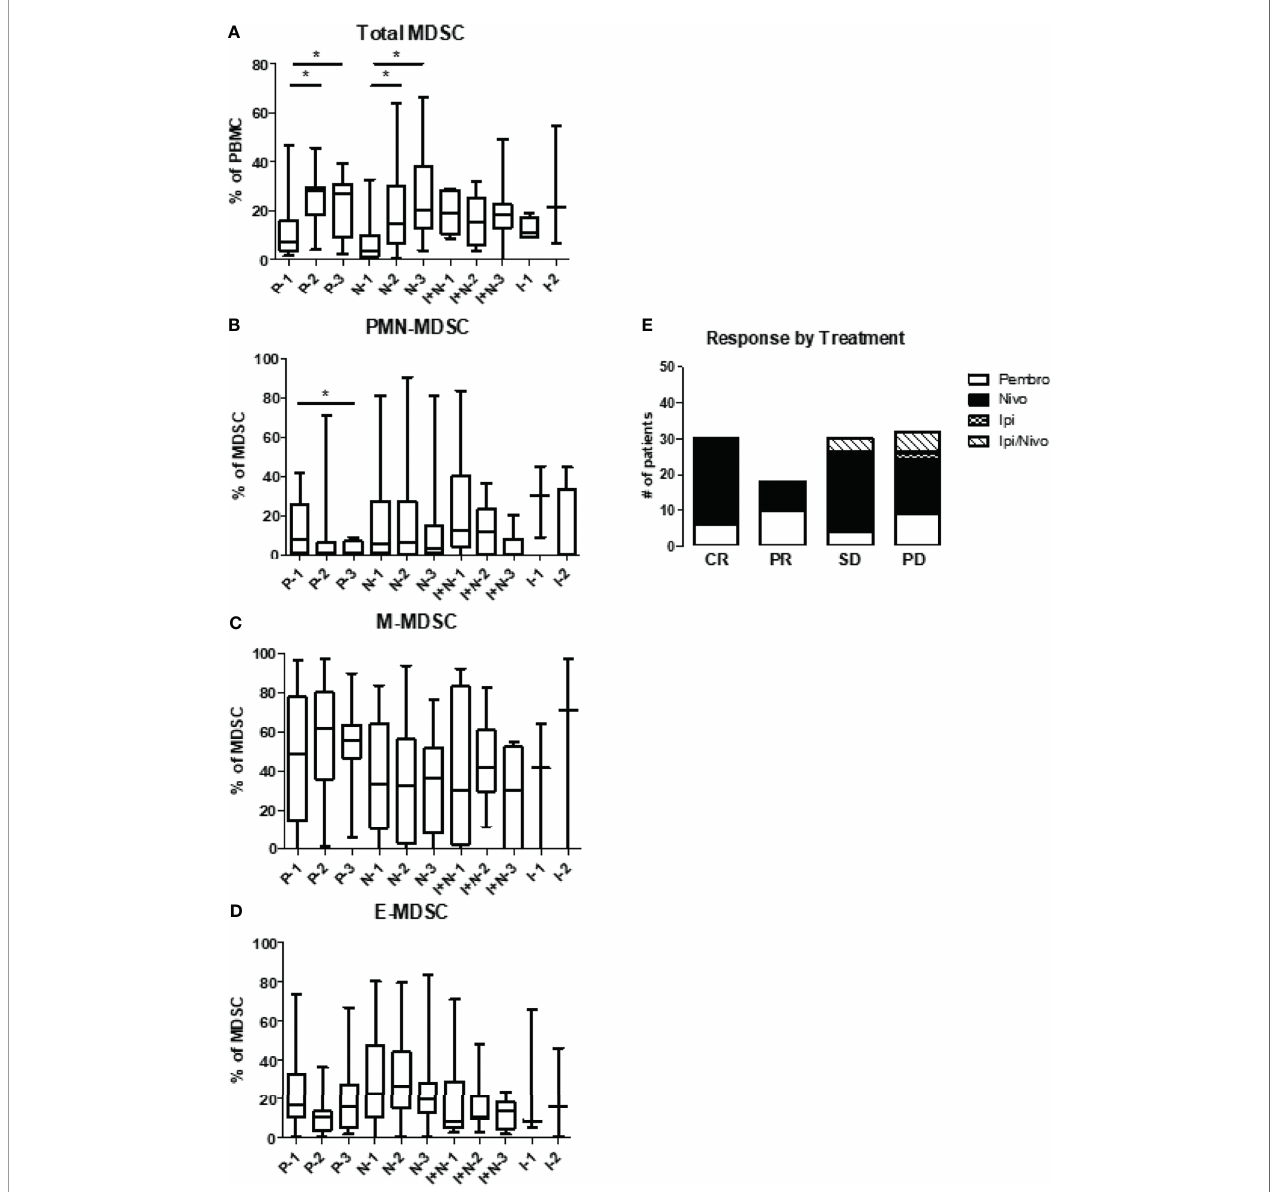
FIGURE 6 | Levels of circulating MDSC based on the type of immunotherapy. Patient PBMCs were evaluated for MDSC levels and analyzed according to type of checkpoint inhibitor therapy received. Patients received either pembrolizumab (Pembro), nivolumab (Nivo), ipilimumab/nivolumab (Ipi/Nivo), or ipilimumab alone (Ipi). Levels of (A) total MDSC (B) granulocytic MDSC (PMN-MDSC), (C) monocytic MDSC (M-MDSC) and (D) early MDSC (E-MDSC) are shown. (E) Clinical response is strati fi ed based on type of immunotherapy given. Data are shown as box and whisker plots with ranges, *p <